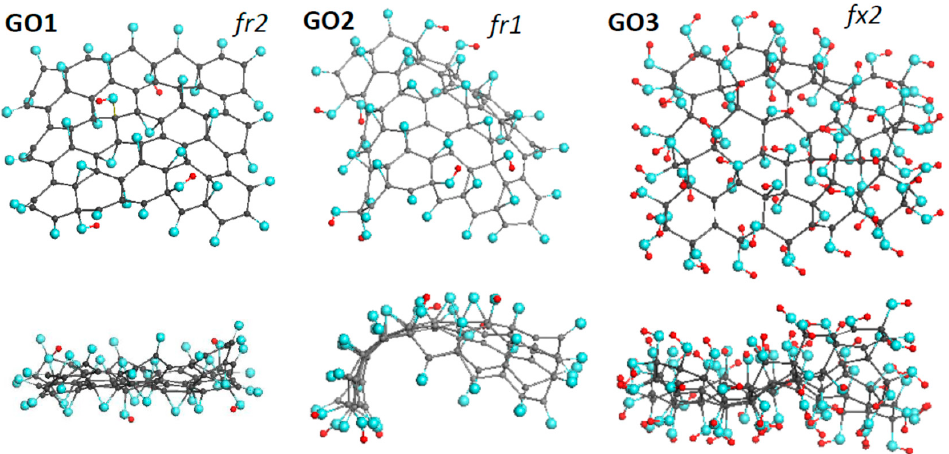
Figure 3. Face and side view of equilibrium structures of virtually synthesized graphene oxides GO1 and GO2, both of C 66 O 40 H 4 content, and GO3 of C 66 (OH) 74 . Gray, blue, and red balls mark carbon, oxygen, and hydrogen atoms, respectively. UHF AM1 calculations.